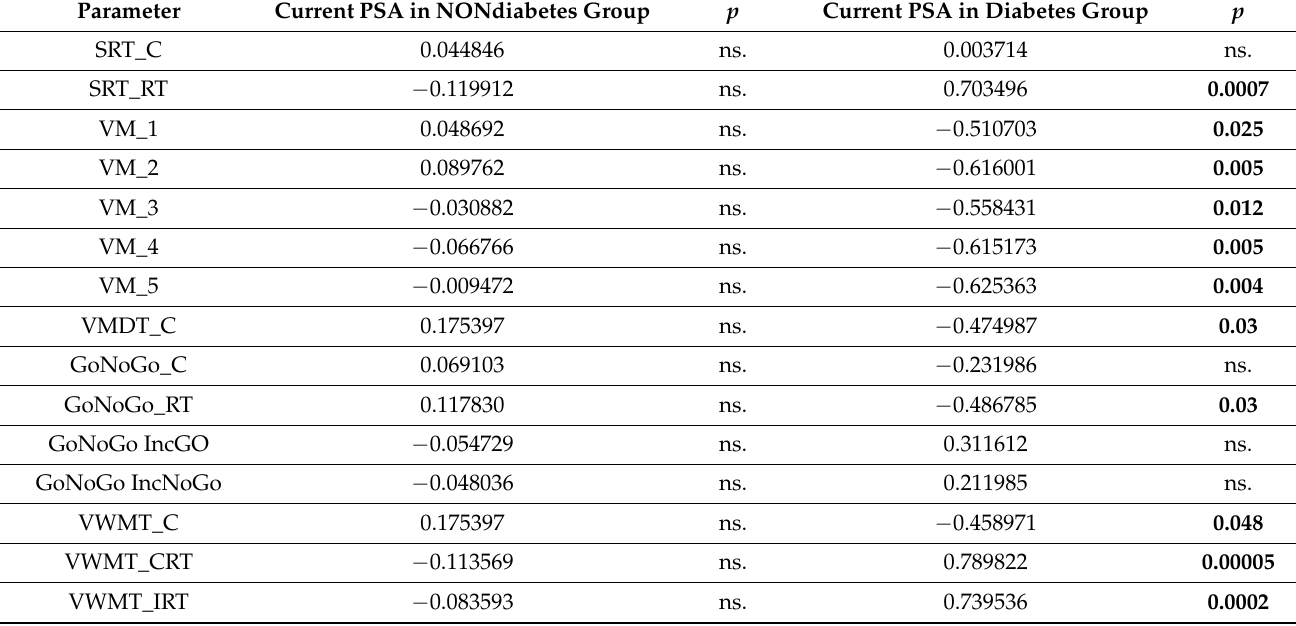
Table 4. R-Spearman correlations of cognitive test results and current PSA level in subgroups with and without